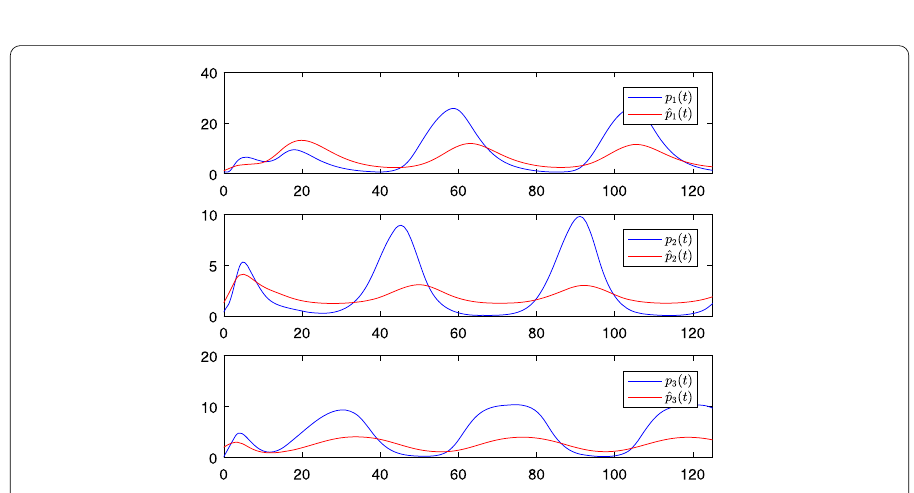
Figure 8 Time response of proteins p i ( t ) ˆ m i ( t ), i = 1,2,3